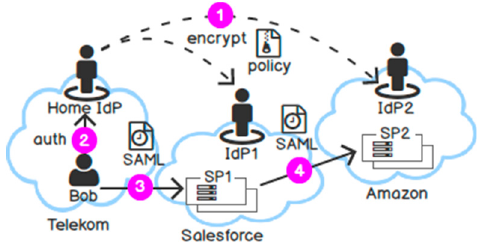
Figure 4. Request flow of Purpose-based Encryption.